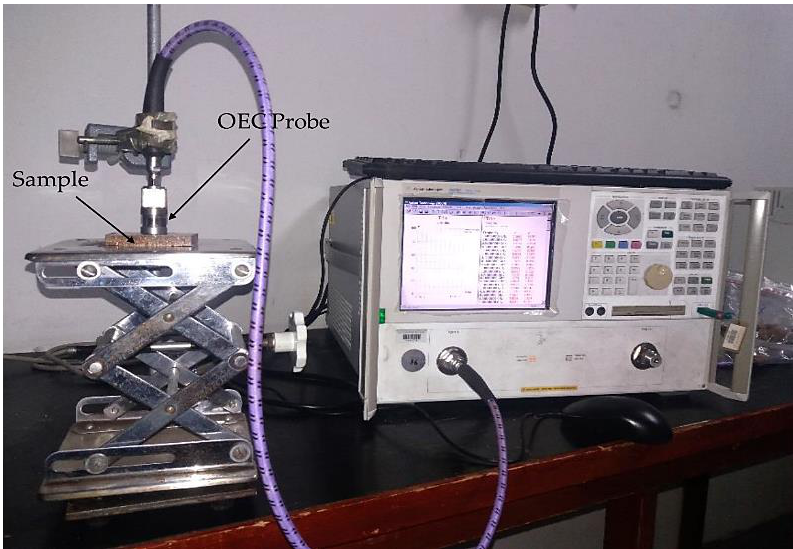
Figure 5. Set-up of relative permittivity measurement using open-ended coaxial probe.